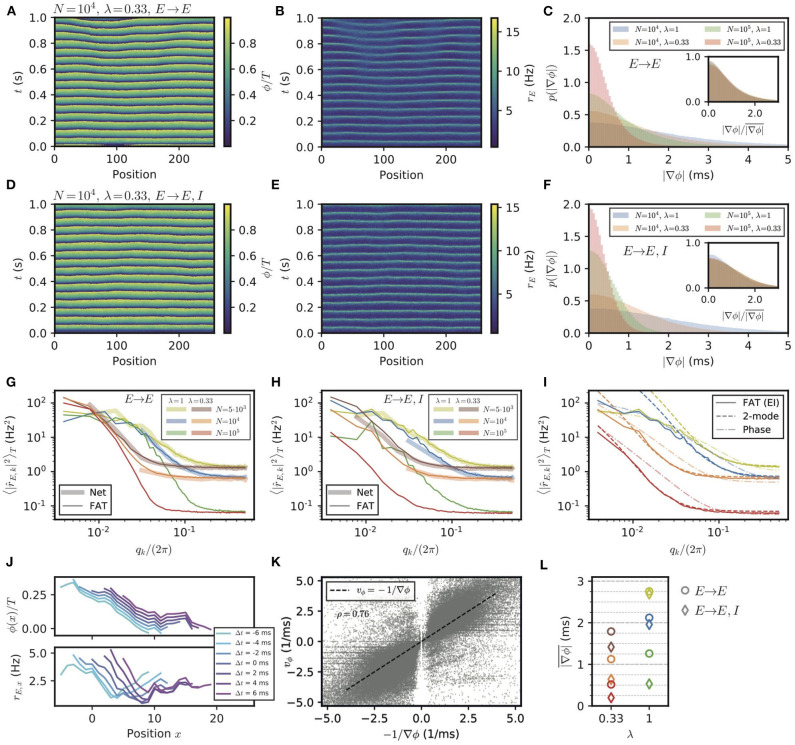
Appearance of phase gradients and stochastic fluctuations in a chain of E–I modules. (A,B) Simulation of the stochastic rate model (FAT) for a chain with E → E connectivity, a space constant λ = 0.33 and network size N = 104. (A) Instantaneous phase as obtained from the Hilbert transform of bandpass-filtered excitatory activity, where the (unfiltered) rates are shown in (B). (C) Distributions of local phase gradients ∇ϕ = ϕx+1 − ϕx for different noise strengths and space constants for E → E connectivity. Inset: distributions of gradients normalized to the respective mean value. (D,E) Phase and excitatory activity for the same parameters as in (A,B) but with E → E, I connectivity. (F) Same as in (C) but for E → E, I connectivity. (G,H) Power spectra of the spatial activity profiles (averaged over 5 s) for different module sizes and space constants λ, for E → E
(G) and E → E, I
(H) activity, respectively. The spectra obtained from spiking network simulations (N = 5, 000: L = 128; N = 104: L = 32) are shown in light thick lines, spectra obtained from rate-model simulations are shown in dark thin lines (L = 256). (I) Comparison of the spectra obtained from simulations (FAT, solid lines) and theoretical predictions for E → E, I connectivity. Similar to the two-module case, the modes with larger effective couplings are well-described by the two-mode calculation (dashed lines, Equation (138)), while for smaller couplings, or vanishing q, non-linear effects due to the periodicity of the limit cycle, which are not captured by the linearized two-mode dynamics, become dominant. This limit is better captured by the phase approximation and taking the periodicity of the limit cycle dynamics into account (dash-dotted lines, Equation 124). Network size N and space constant λ as in (G,H). (J) Example of a spatially extended phase gradient (upper panel) that gives rise to the apparent propagation from left to right of a (negative) bump of activity in space (lower panel). Phase and excitatory firing rate are shown over a length of 15 modules for different instances in time, see color code legend. (K) Correlation of spatially extended phase gradients ∇ϕ¯ (averaged over five modules and retained when the absolute average gradient is larger than the standard deviation of local phase differences) with phase propagation velocities vϕ determined from frame-to-frame correlations between spatial phase profiles (see Methods). (L) Summary plot of average phase gradients for different network sizes N and connection decay space constants λ for E → E connectivity (circles) and E → E, I connectivity (diamonds).